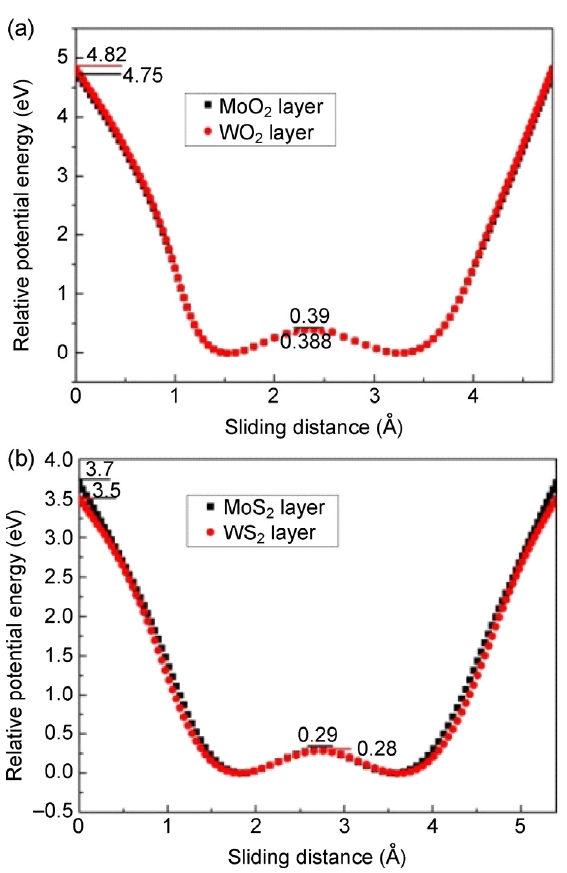
Fig. A1 (a) Relative sliding potential energy curves of transition metal dioxides when interlayer distance decreases 0.5 Å. (b) Relative sliding potential energy curves of transition metal disulfides when interlayer distance decreases 0.5 Å.